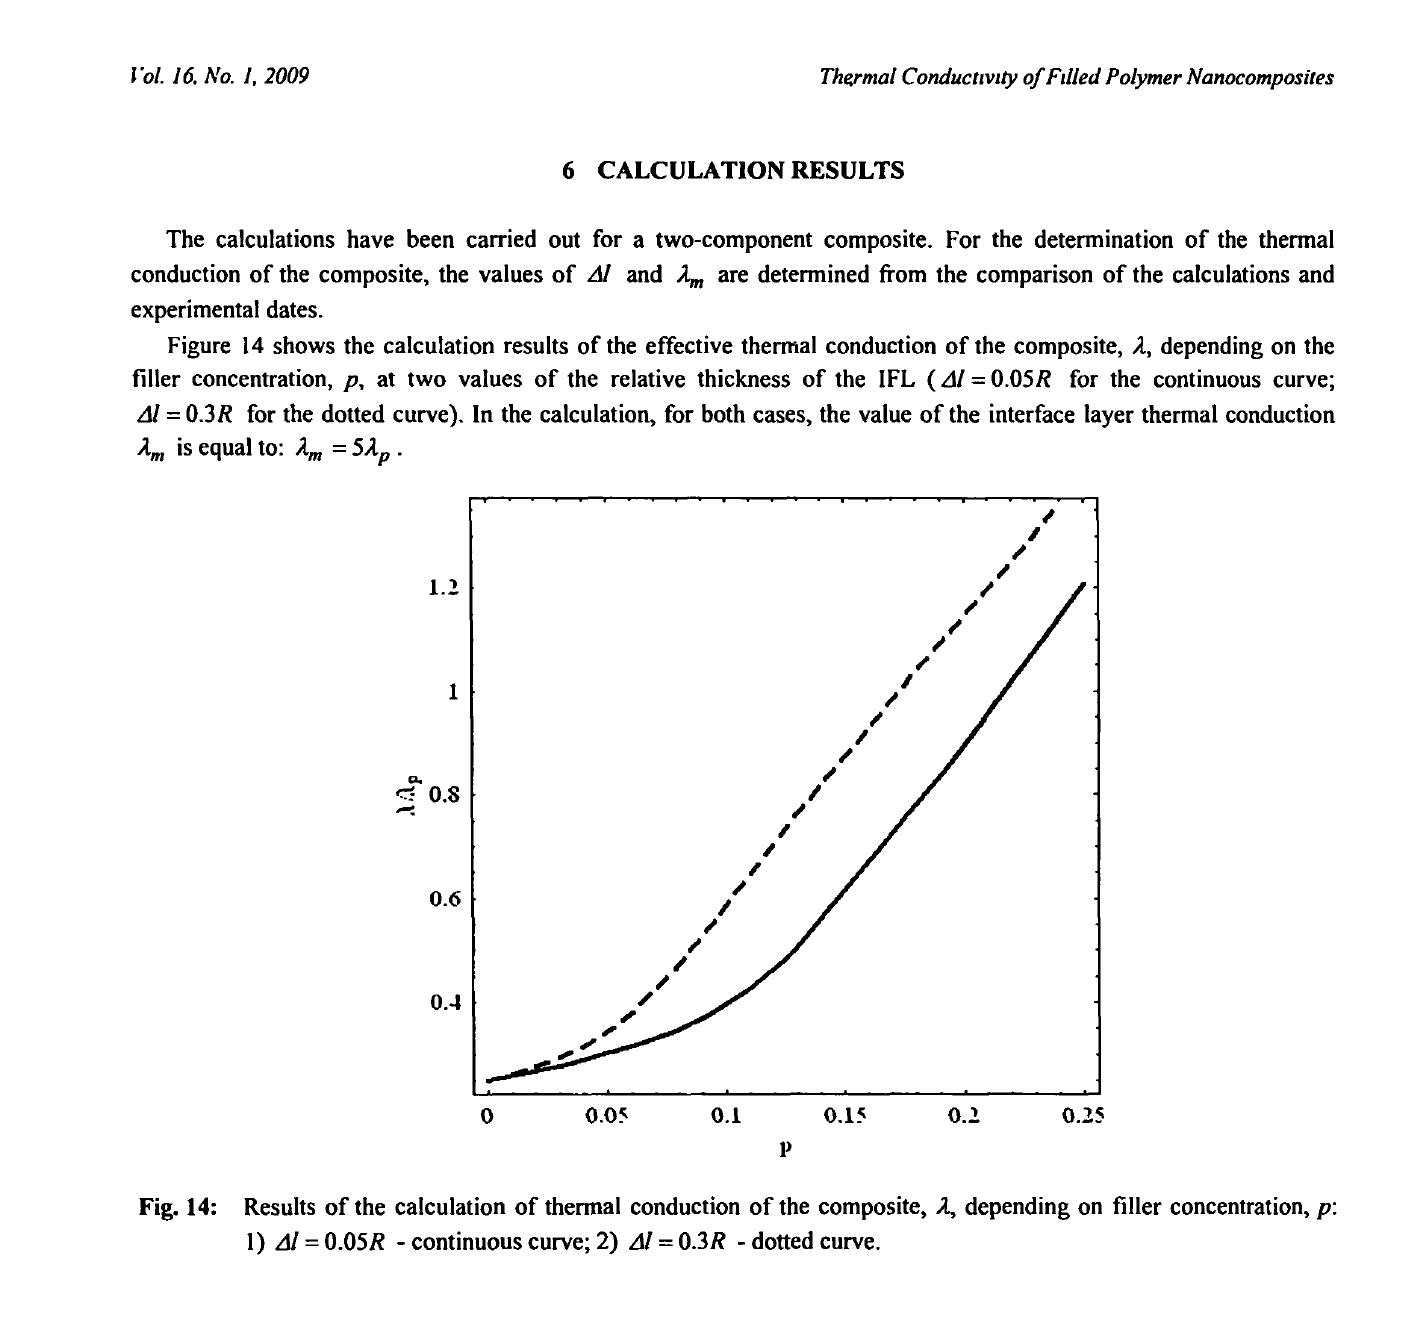
Fig. 14: Results of the calculation of thermal conduction of the composite, A, depending on filler concentration, p: 1) Al = Q.Q5R - continuous curve; 2) Al = Q.3R - dotted